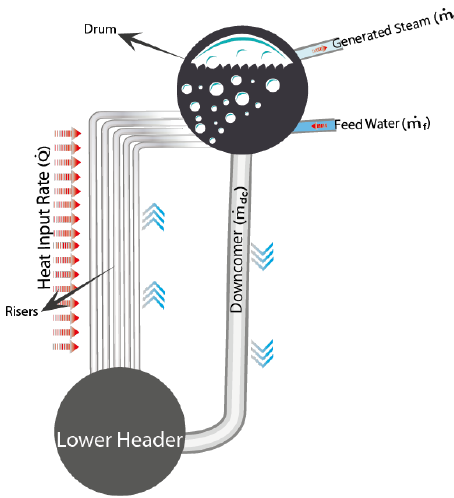
Figure 2. Schematic representation of the steam generator. Equation (1) represents the overall mass balance in the drum and Equation (2), the global energy